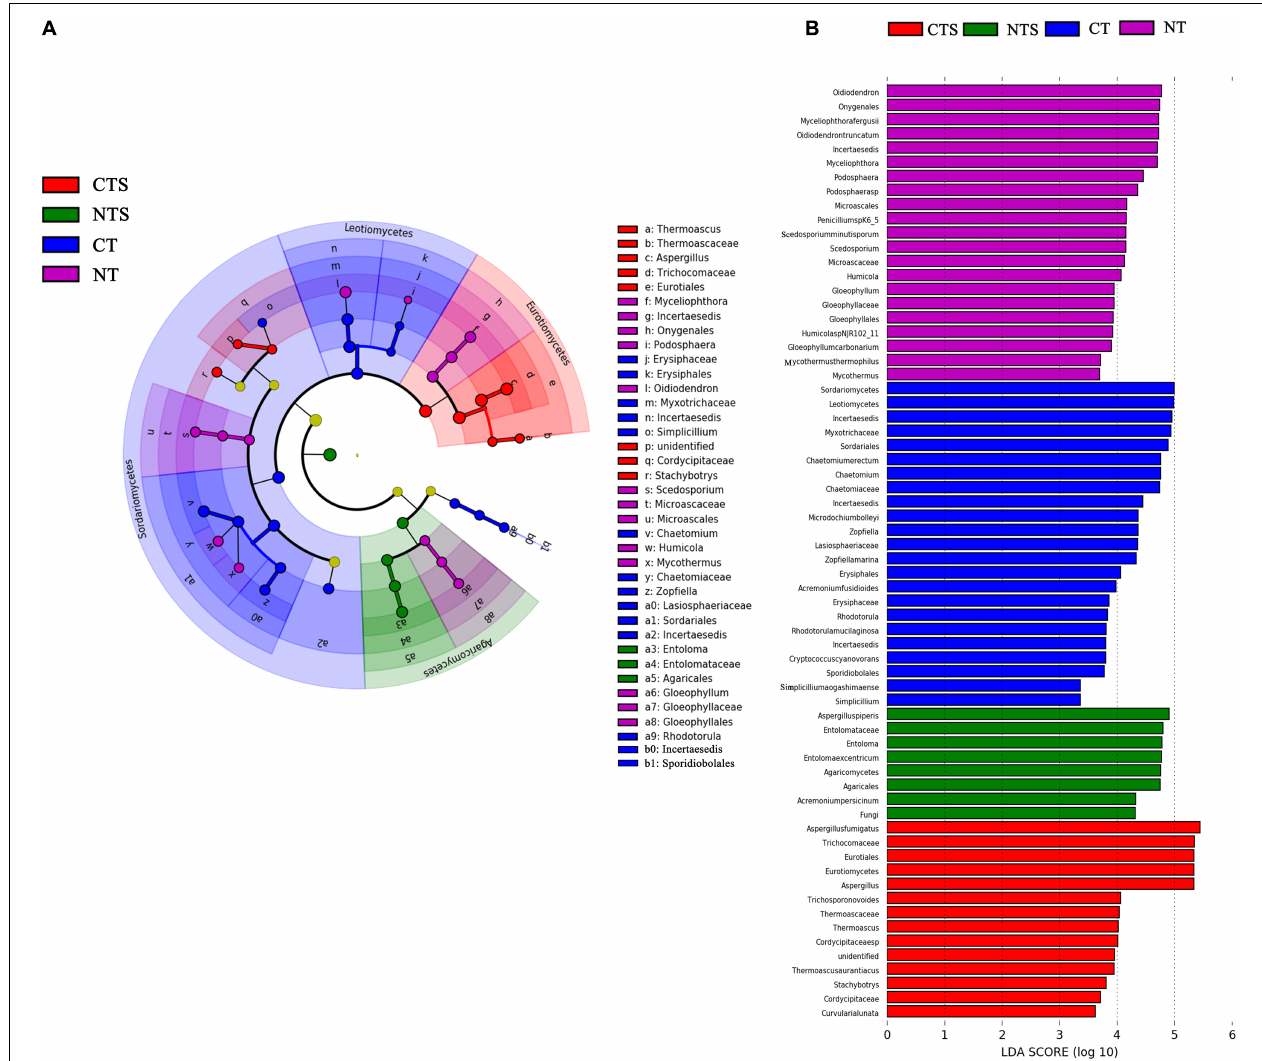
FIGURE 3 | Cladogram showing the phylogenetic distribution of the fungal lineages associated with soil from the four treatments (A) . Indicator fungi with LDA scores > 3 (B) . Different colors represent different treatments (red, CTS; green, NTS; blue, CT; purple, NT). The circle from inside to outside represents phylogenetic levels from domain to genus, with its diameter reflecting the relative abundance of